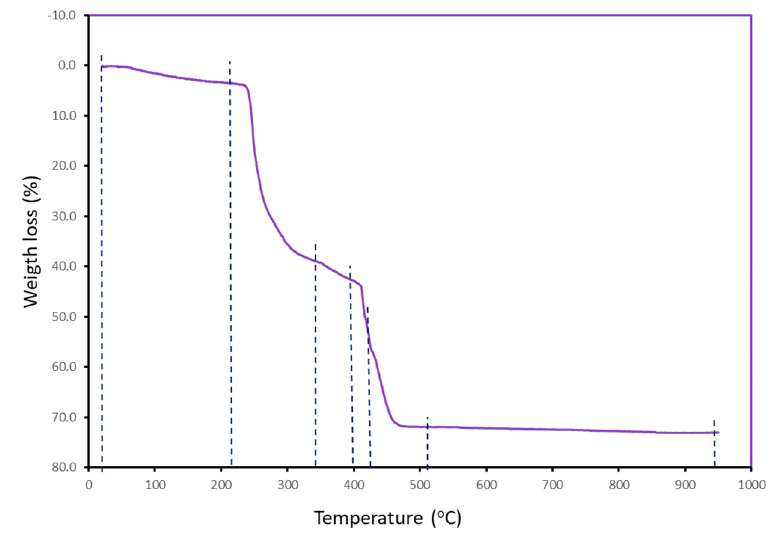
Figure 1. Weight loss versus temperature (in the range r.t. to 950 °C) in the thermo-gravimetric analysis (TGA) analysis of 1 (sample: 11.03 mg). Table 2. Summary of results obtained from the thermogravimetric analysis of compound 1 . Step or R Temp. (°C) Time (min)